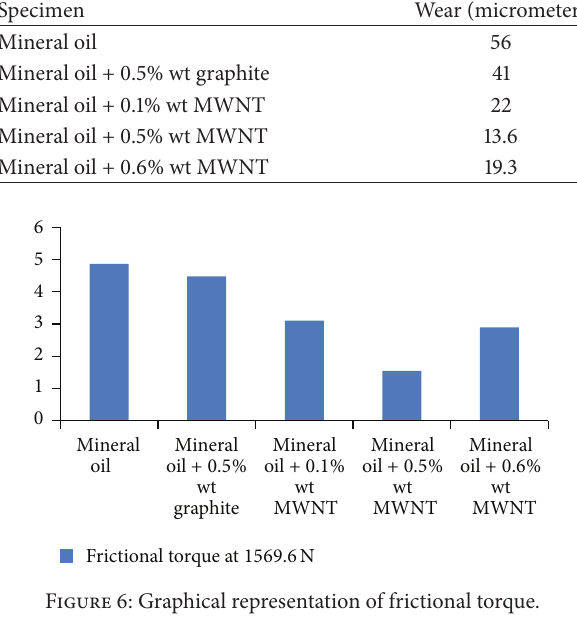
Figure 6: Graphical representation of frictional torque.